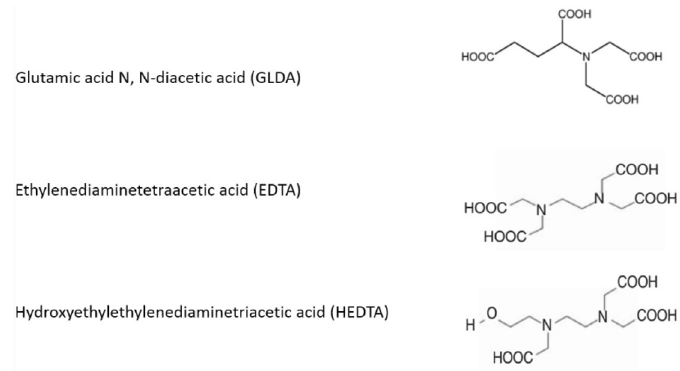
Fig. 1 Chelating agents (HEDTA, EDTA, and GLDA) structure (Mahmoud 2017)